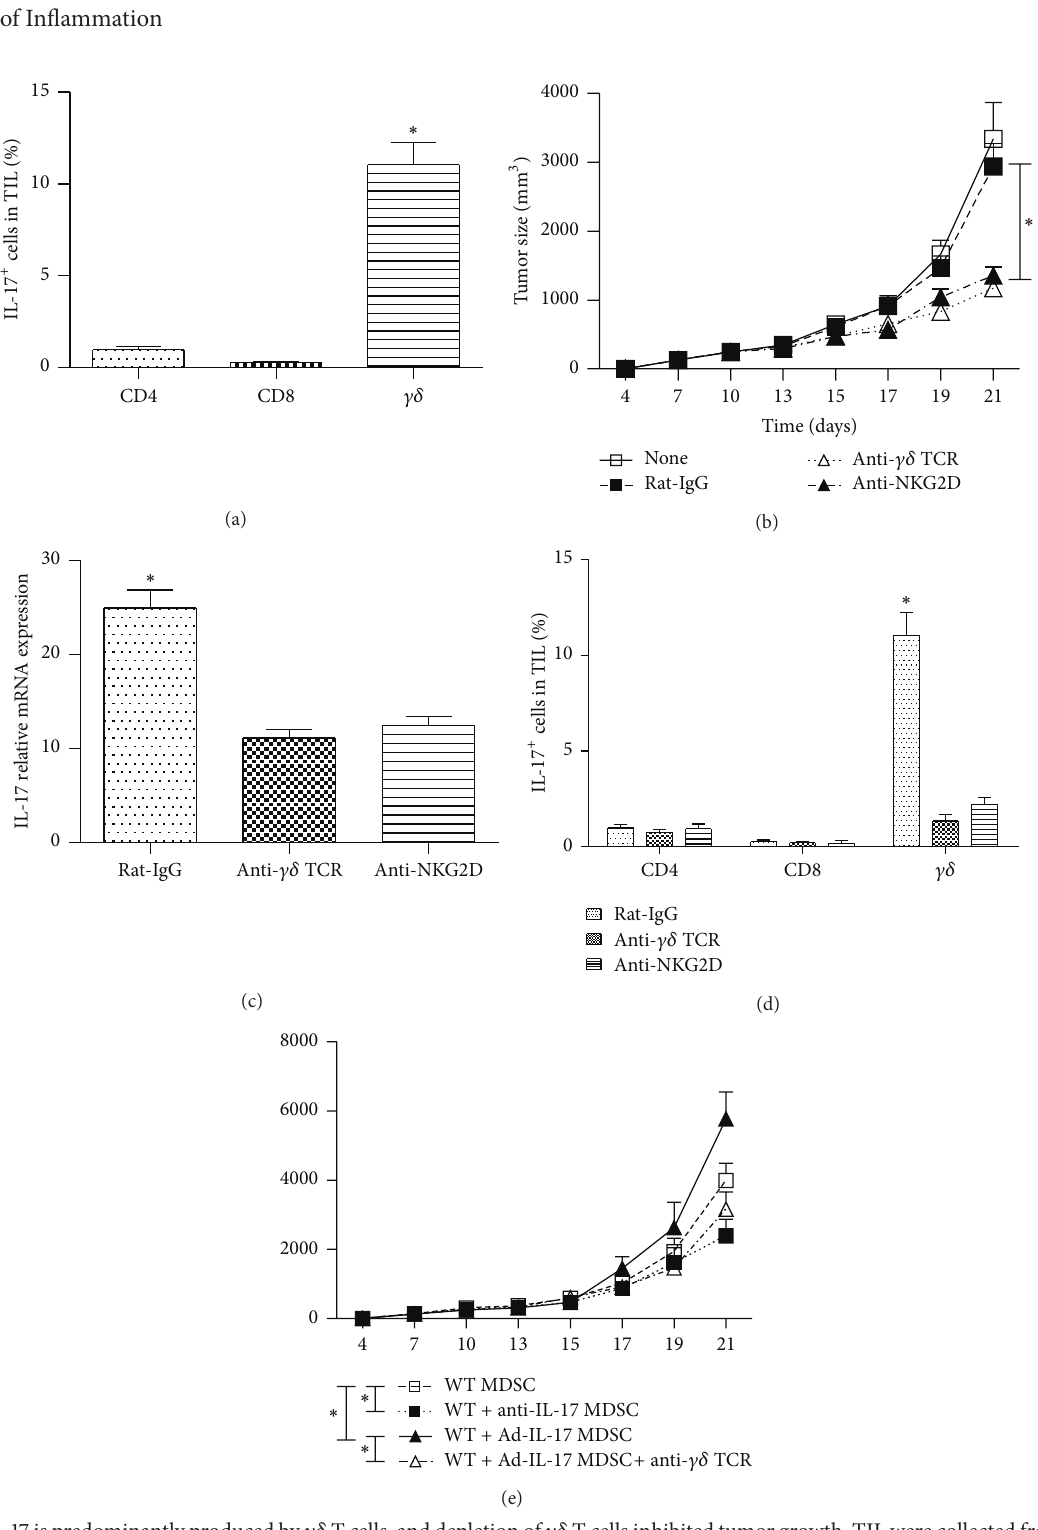
Figure 2: IL-17 is predominantly produced by 𝛾𝛿 T cells, and depletion of 𝛾𝛿 T cells inhibited tumor growth. TIL were collected from B16-F10 tumor tissues 2 weeks after B16-F10 tumor cell inoculation. IL-17-producing cells in each T-cell subset were detected by intracellular staining assay. (a) The percentage of cells producing IL-17 ( 𝑛 = 5 ). (b) Wild-type mice were inoculated with B16-F10 tumor cells and injected i.p. with normal rat-IgG or a rat anti-mouse 𝛾𝛿 TCR mAb or anti-mouse NKG2D mAb (100 𝜇 g/mouse) on days 0, 1, 6, 10, and 14 ( 𝑛 = 5 ). Then tumor sizes were monitored. (c) IL-17 relative mRNA expression in tumor tissues from B16-F10 tumor-bearing mice treated with rat-IgG, - 𝛾𝛿 TCR, or -NKG2D mAb ( 𝑛 = 5 ). (d) The percentage of cells producing IL-17 in control, anti- 𝛾𝛿 TCR, and anti-NKG2D treated group ( 𝑛 = 5 ). (e) Tumor growth in B16 tumor cells inoculated mice from WT MDSC, WT + anti-IL-17 MDSC, WT + Ad-IL-17 MDSC, and WT + Ad-IL-17 MDSC + anti- 𝛾𝛿 TCR groups ( 𝑛 = 5 ). The data show means ± SEM of tumor size and are representative of three independent experiments. ∗ 𝑃 < 0.05